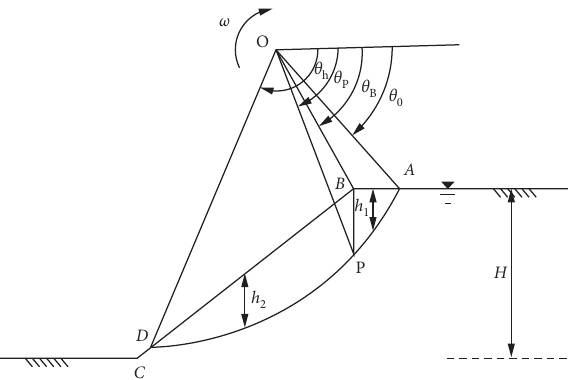
Figure 4: Symmetry plane of face-failure mechanism with ground